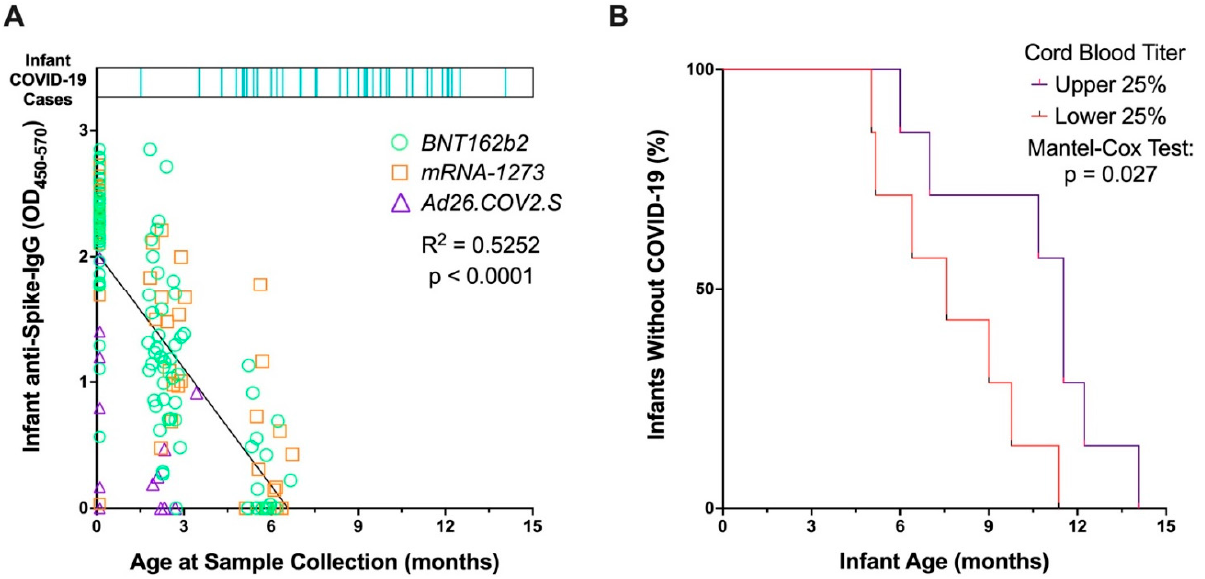
Figure 1. Relationship between infant anti-Spike titers from maternal vaccination and infant infection with SARS-CoV-2. ( A ) Timeline of COVID-19 onset in infants are shown in top bar, with each infant who developed COVID-19 depicted by a vertical blue line, with line position along the x -axis indicating age at SARS-CoV-2 infection. Bottom section displays infant anti-Spike IgG titers from maternal vaccination, measured in cord blood (age zero) and at two and six months of age. Units for infant anti-Spike IgG are OD 450–570 , which correspond to the optical density at 450 nm corrected from a reference wavelength of 570 nm. Symbols and colors are grouped by maternal vaccination platform: Green circles are for Pfizer (BNT162b2), orange squares for Moderna (mRNA-1273), purple triangles for Johnson & Johnson (Ad26.COV2.S). Analysis was performed by a simple linear regression. ( B ) Kaplan–Meier curve displays time to SARS-CoV-2 infection of infants who developed COVID-19, grouped by those who displayed high anti-Spike IgG titers in cord blood at birth (upper quartile) and those who displayed low anti-Spike IgG titers in cord blood (lowest quartile). Infants who developed COVID-19 with anti-Spike IgG titers from cord blood in the top quartile are more likely to experience a longer infection-free interval than infants with titers in the bottom quartile ( p = 0.027). Analysis between groups was performed by a Mantel-Cox test.